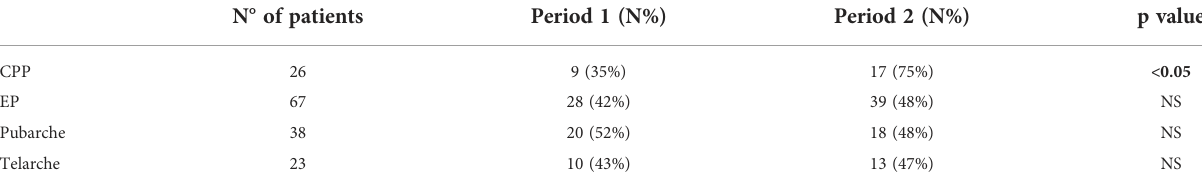
TABLE 1 Frequency of different diagnoses of precocious puberty in Period 1 and Period 2. N° of